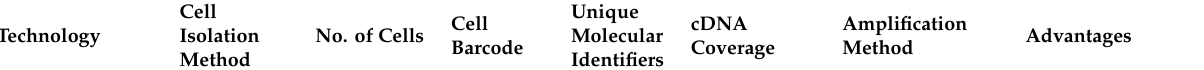
Table 1. Summary of conventional scRNA-seq